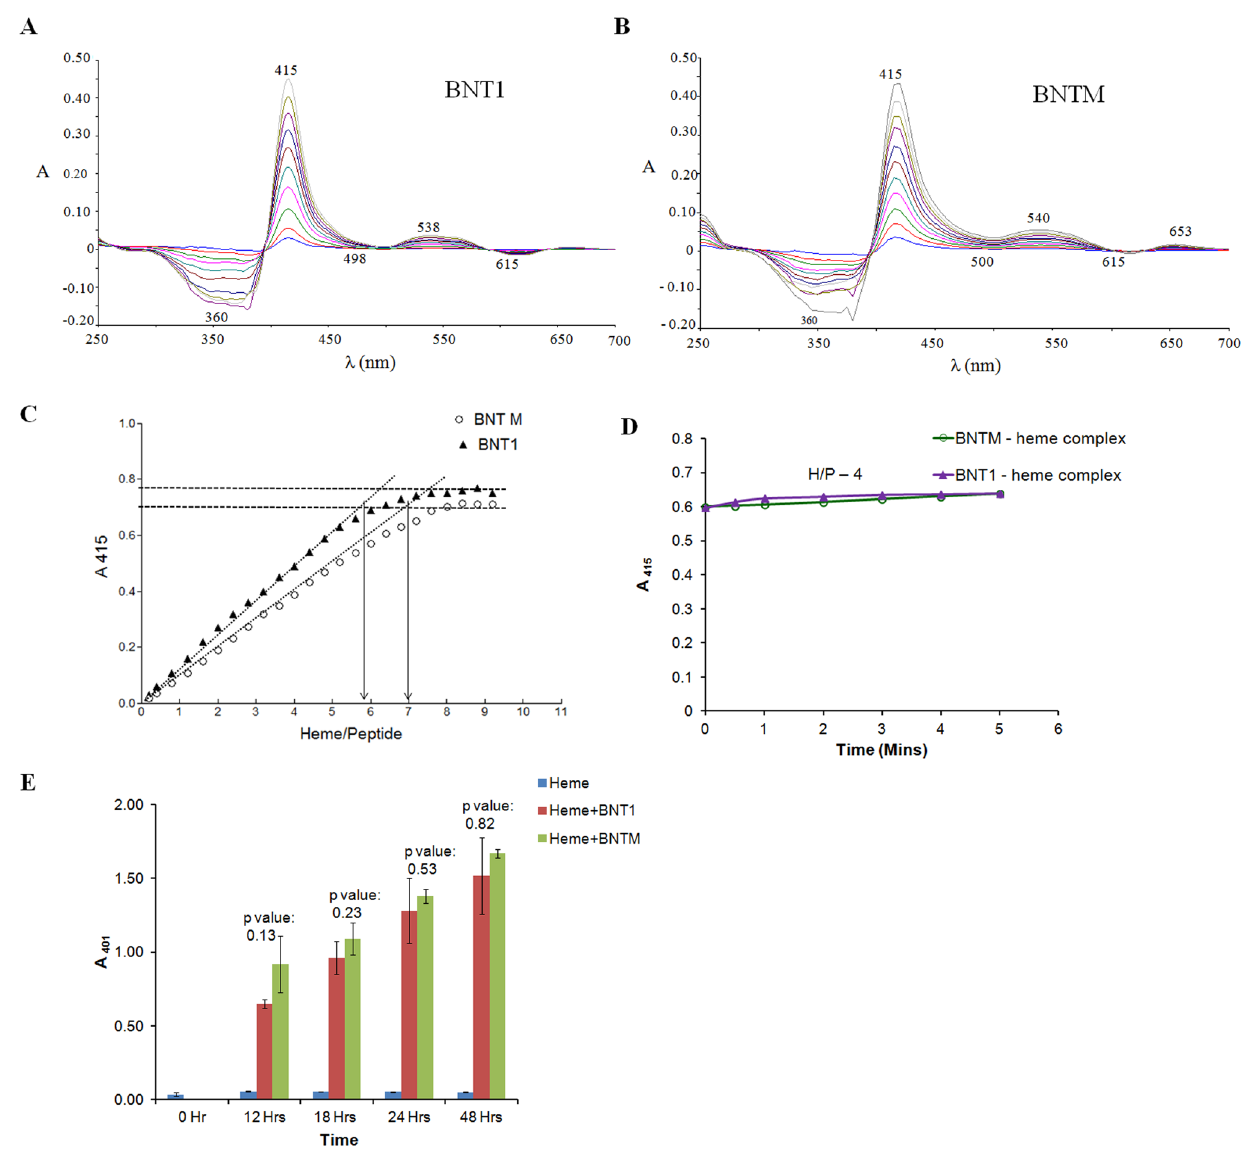
Figure 2. Difference Spectroscopic Titration and formation of b -hematin. Panels A and B show difference absorption spectra of heme binding to BNT1 and BNTM respectively. Panel C shows heme-binding curves of BNT1 and BNTM generated from the difference absorption spectra by plotting A 415 vs the moles of heme/mole of peptide template. Horizontal lines were drawn connecting the Y axis to the plateau region of the binding curves. At the point of intersection, vertical arrows were drawn to obtain the values of heme/peptide.Panel D shows comparative kinetics of heme binding to BNT1/BNTM (at heme: peptide molar ratio of 4) studied by difference spectroscopy. Data shows intensity of Soret peak as a function of time. Panel E shows comparative kinetics of b -hematin formation in presence of